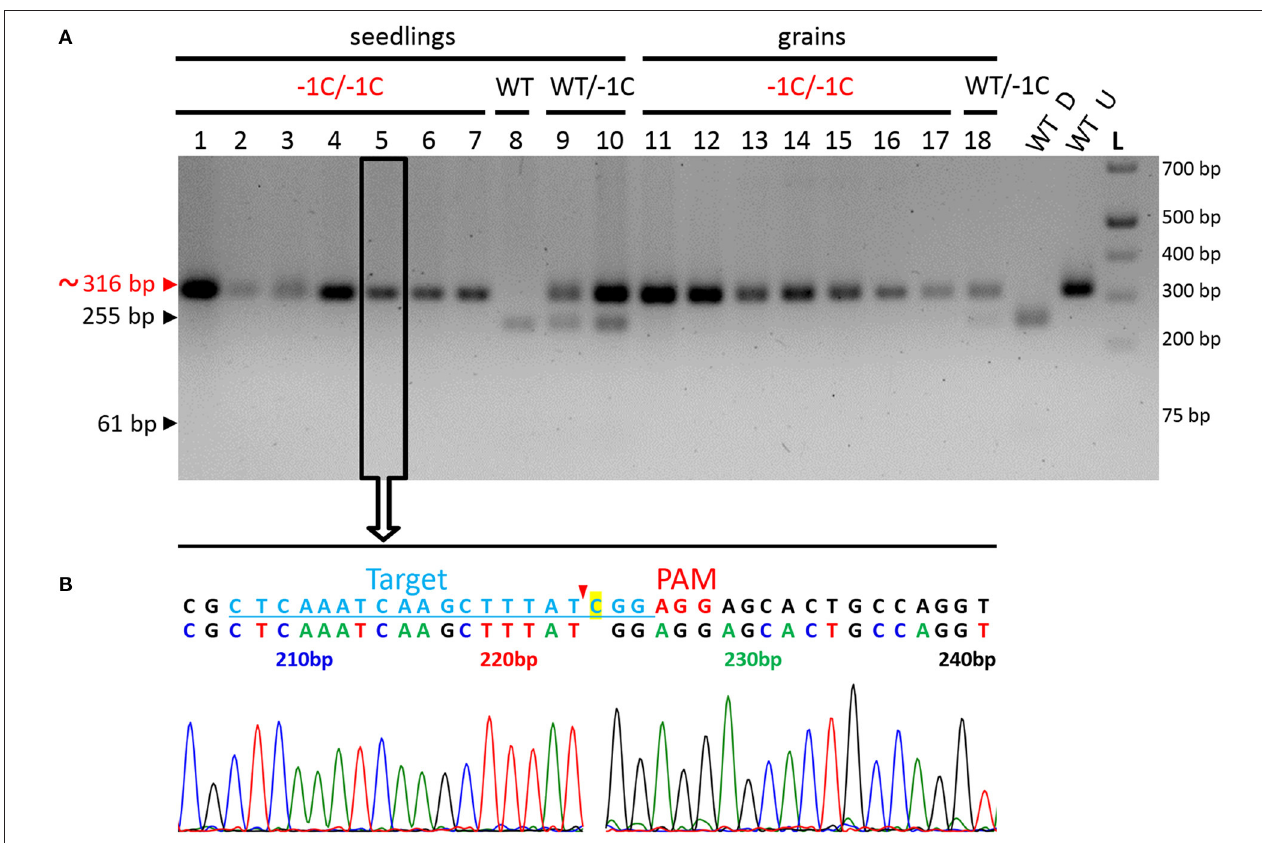
FIGURE 7 | Genotyping of the seedlings and grains removed from the soil for the on-target mutations in the HvMPK6 gene-representative results. (A) PCR-RE genotyping. Seedlings and grains were removed from the soil 3 weeks after sowing. Genomic DNA for the analysis was extracted from the small leaf blade-like structure/structures, seeds’ leftovers without husk and roots of seedlings and from the grains without husk. About 316-bp PCR amplicons of the genomic region covering the on-target site, which were associated with 10 seedlings (1–10), and eight grains (11–18) were digested with Hpy 188I. The red arrowhead and red typing of the size of the PCR product indicate the undigested PCR amplicons contaning mutation which disrupts the Hpy 188I recognition site. The black arrowheads and black typing of the sizes of the PCR products indicate the digested WT PCR amplicons. Wt D—digested and Wt U—undigested reference 316-bp amplicons associated with a WT plant. L-O’GeneRuler 1kb Plus DNA Ladder (Thermo Fisher Scientific, Waltham, MA, USA). Sizes of the selected ladder fragments are shown on the right. Seven seedlings and seven grains were homozygous knockout mutants in the HvMPK6 gene ( − 1C/ − 1C). One seedling was WT (WT/WT), two were heterozygotes (WT/ − 1C), and one grain was a heterozygote (WT/ − 1C). All 18 PCR amplicons were also sequenced (an example for a − 1C/ − 1C mutant in an open rectangle with an arrow). (B) Single sequencing chromatogram associated with the − 1C/ − 1C seedling. Above the chromatogram, deduced color-coded nucleotide sequence and reference WT nucleotide sequence including the position of the on-target site (underlined lightly blue typing) and the PAM site (red typing) are shown. The nucleotide numbering is shown as the distance in bp from the first nucleotide of the K6E3_F1 primer site. Cas9 endonuclease from S. pyogenes cleaves target DNA sequences most frequently after the third nucleotide upstream of a PAM site ( Jinek et al., 2012; Ran et al., 2015) (red arrowhead). Single base pair CG deletion (“C” highlighted in yellow in a reference sequence) occurs next to the cleavage site at the third nucleotide position upstream of the PAM site. Deduced nucleotide sequence corresponds to the WT nucleotide sequence except for the CG